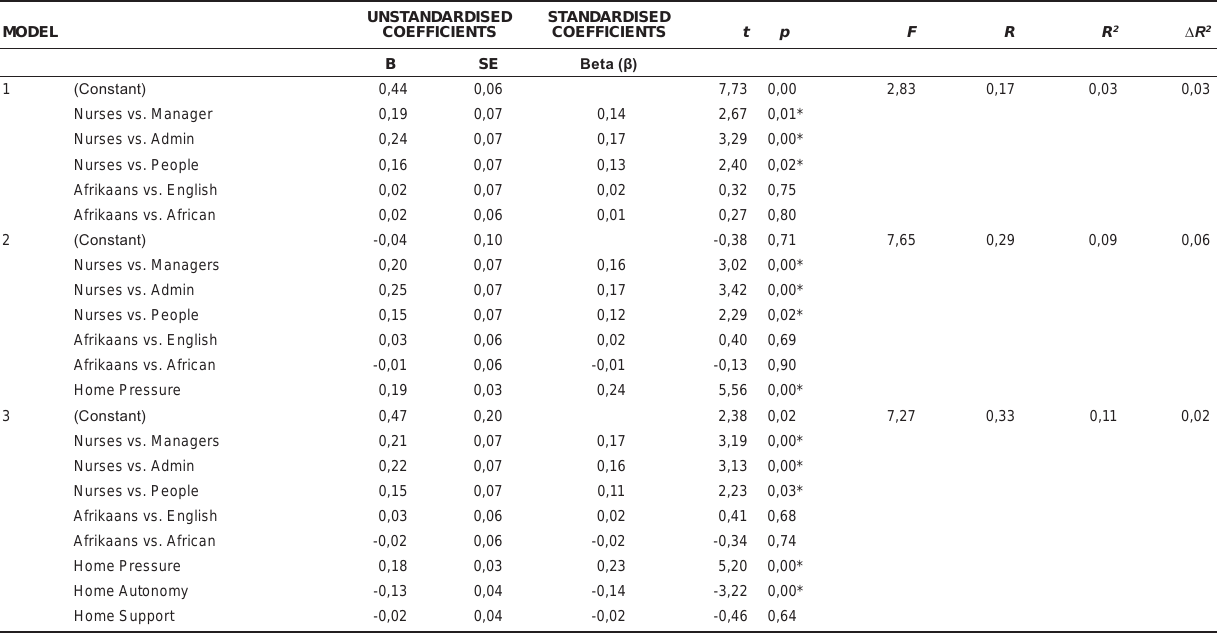
taBLe 6 Multiple regression analyses with negative HWI as dependent variable